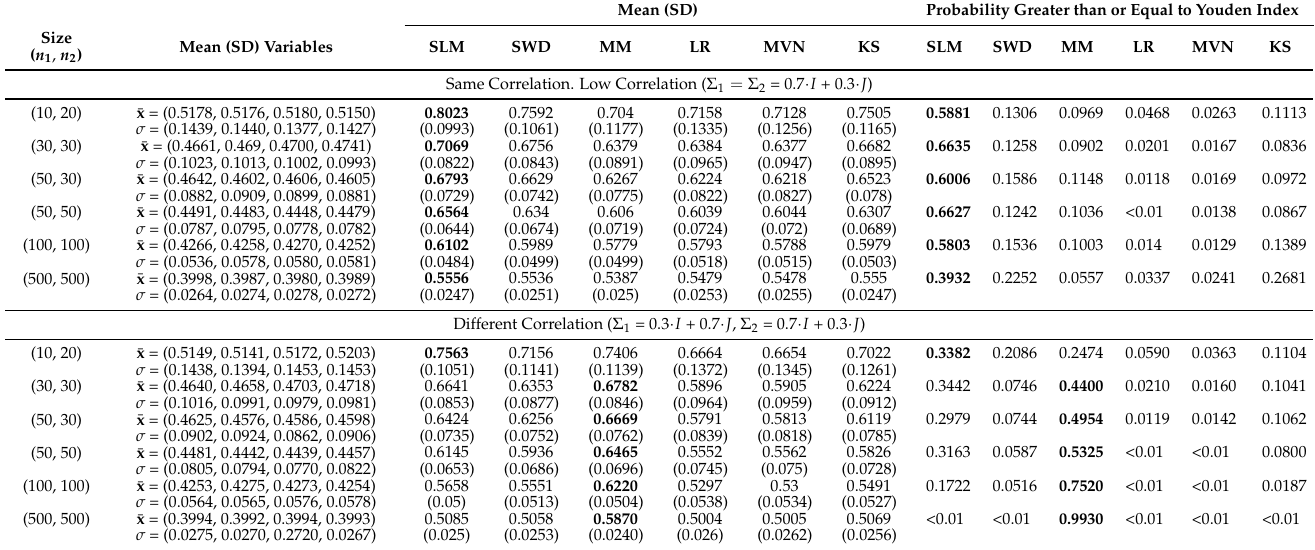
Table 8. Normal distributions: Same means: m 1 = ( 1.0,1.0,1.0,1.0 ) T